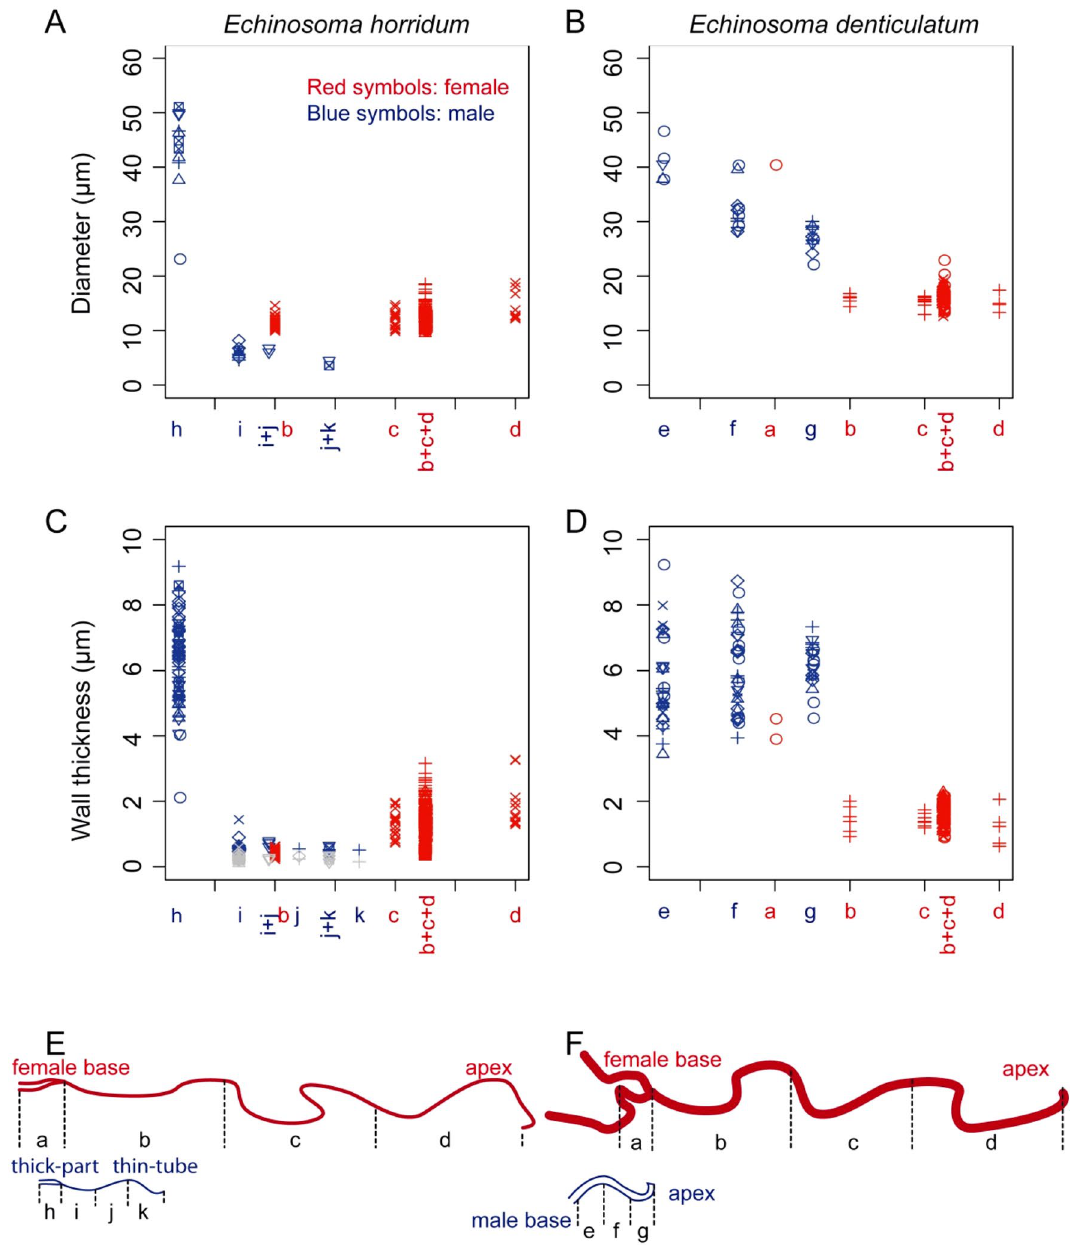
Figure 7. Geometry of the virga and spermatheca of Echinosoma horridum ( A , C , E ) and E. denticulatum ( B , D , F ). ( A , B ) Outer diameters of the virga and spermatheca. ( C , D ) Wall thicknesses of the virga and spermatheca. These were not constant along circumferences in the thin-tube of the virga of E. horridum , and larger wall thicknesses and smaller ones are shown respectively with blue and grey colouration in ( C ). Each symbol in ( A – D ) represents data from one individual. The letters correspond to locations, whose diameters were measured and shown in schemes of the virga and spermatheca ( E , F ). Since it was impossible to measure wall thicknesses and diameters for each area separately, we needed to categorise some areas together, i.e. i + j, j + k and b + c + d. Physically interacting areas between the virga and spermatheca during mating are depicted as overlapped each other in every